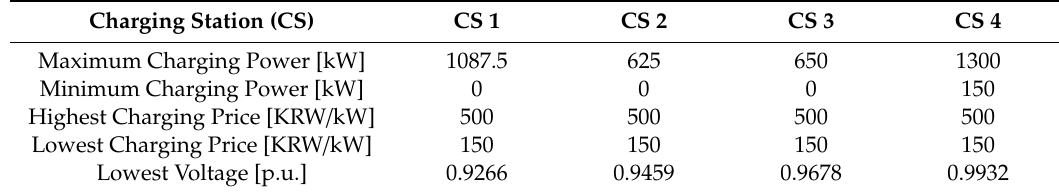
Table 4. Summary of simulation results for Case 3.